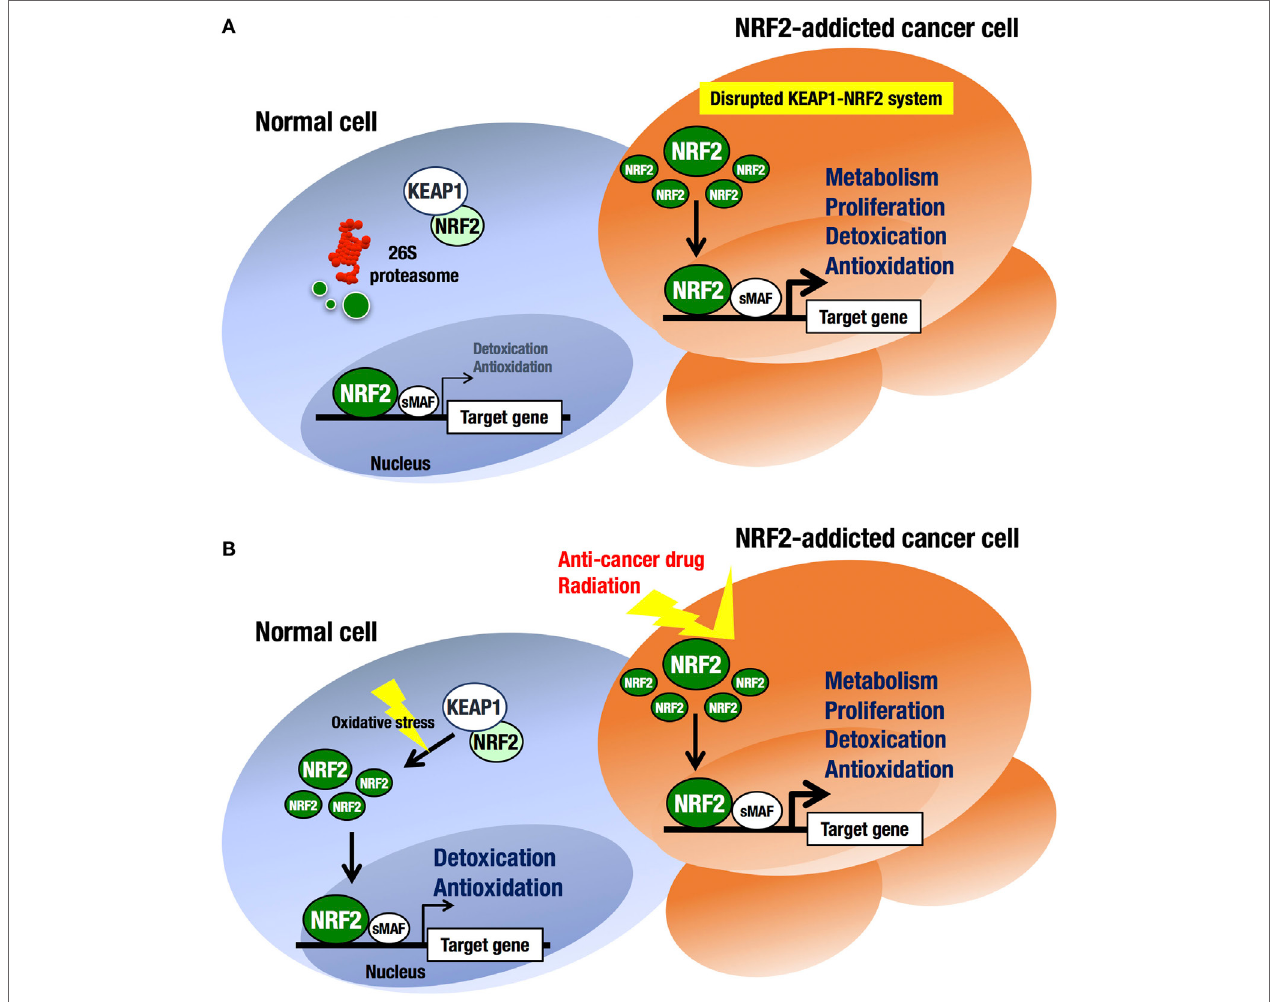
FigURe 3 | Difference in NRF2 activation between normal cells and NRF2-addicted cancer cells . (A) Unstressed condition. The intracellular NRF2 level is very low in normal cells. In contrast, constitutive NRF2 activation in cancer cells accelerates proliferation and metabolism. (B) Oxidative stress-exposed condition. In normal cells, the cellular NRF2 level is temporarily increased upon exposure to toxic (often electrophilic) chemicals and ROS. In contrast, constitutive NRF2 activation confers resistance on cancer cells to anticancer drugs and